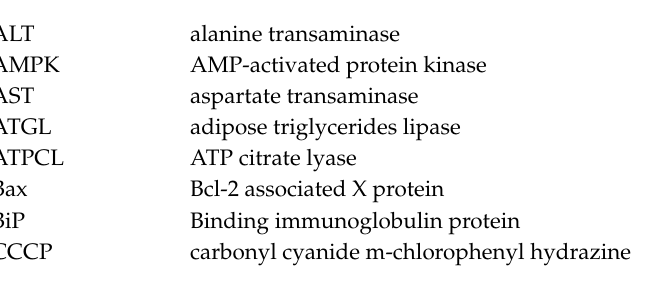
Figure S1: Comparison of body weight and of liver to body weight ratios; Figure S2: Unabridged western blot images; Table S1: Composition of standard and choline-deficient high-fat diets; Table S2: Description and source of antibodies used in the study; Table S3: Description and source of semi-quantitative PCR